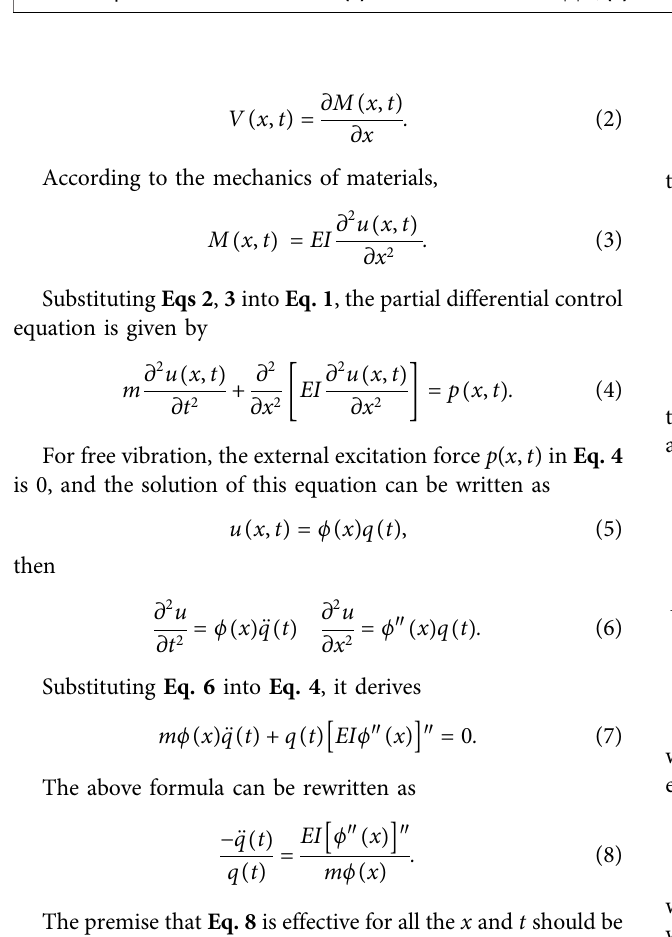
FIGURE 1 | Bernoulli – Euler beam model: (A) coordinates of the CFRP pipe; (B) force state of the in fi nitesimal